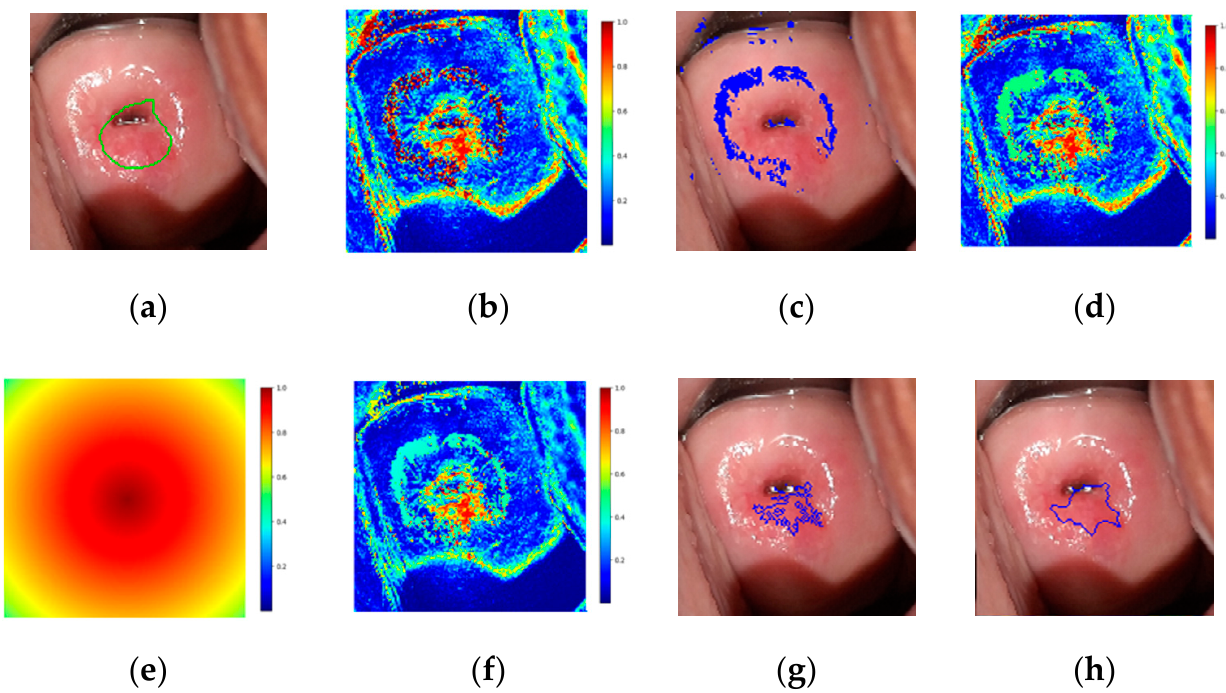
Figure 5. ( a ) Ground truth label drawn in the image corresponding to one minute, ( b ) probability map, ( c ) detected reflections, ( d ) probability map after identifying reflections, ( e ) distance map, ( f ) modified probability map after multiplying by the distance map, ( g ) region growing segmentation results, ( h ) resulting prediction after closing operation drawn in the image corresponding to one minute.